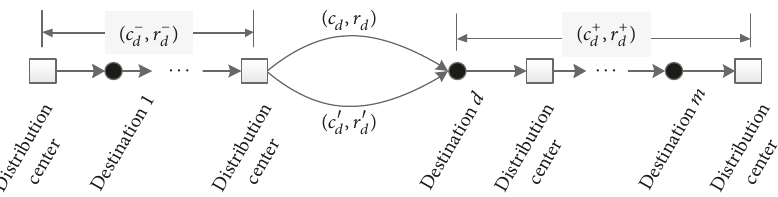
Figure 2: Total cost and total risk of path formed by connecting the distribution center with each destination.